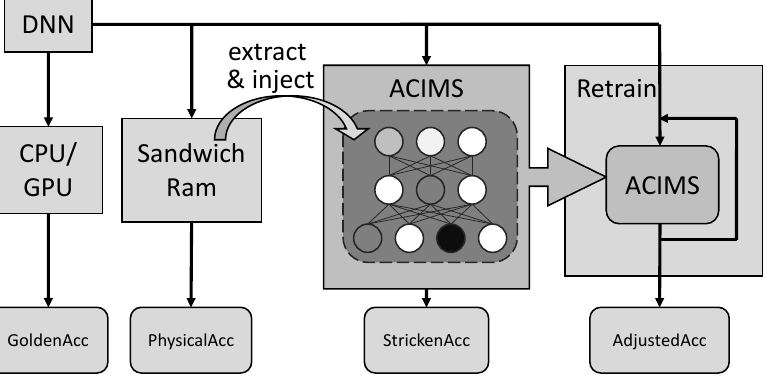
Figure 4. Flow Diagram of ACIMS. ACIMS provides four kinds of accuracy: GoldenAcc (from traditional processors), PhysicalAcc (from ACIM devices), StrickenAcc (from fault injected model) and AdjustedAcc (from the adjusted fault